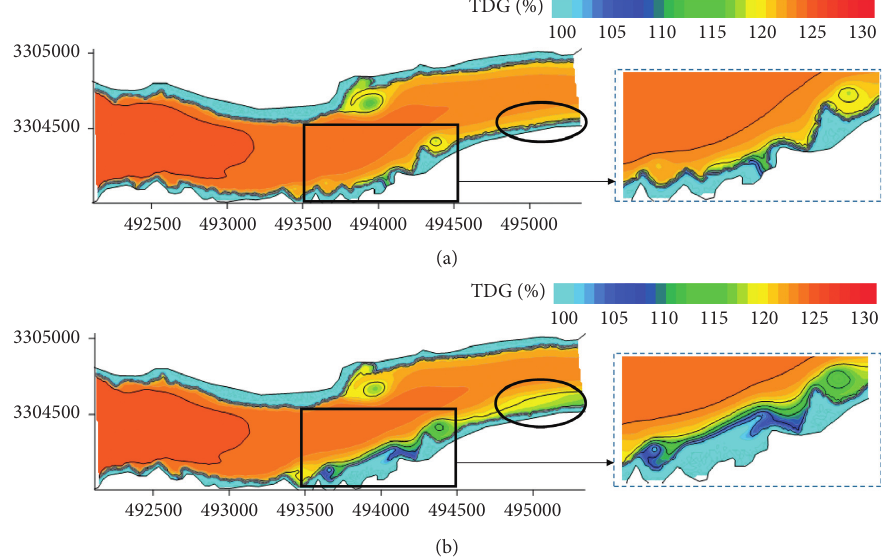
Figure 5: Comparison of TDG distribution. (a) Before the regulation. (b) After the